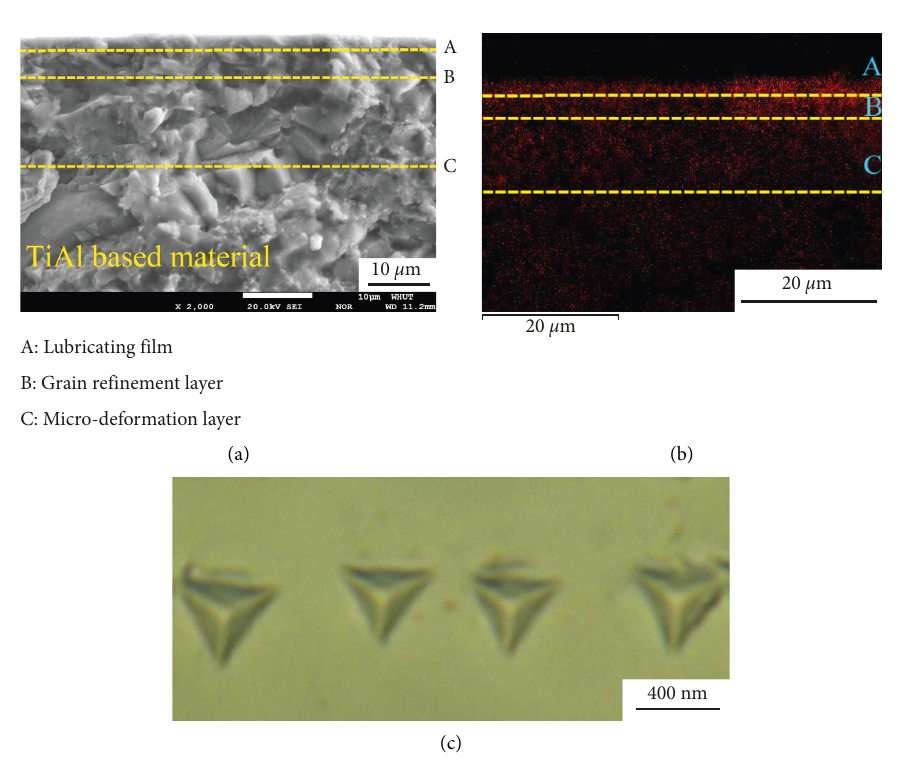
Figure 5: Typical EPMA morphology (a), silver distribution (b), and indentation cross-section morphology (c) of the wear